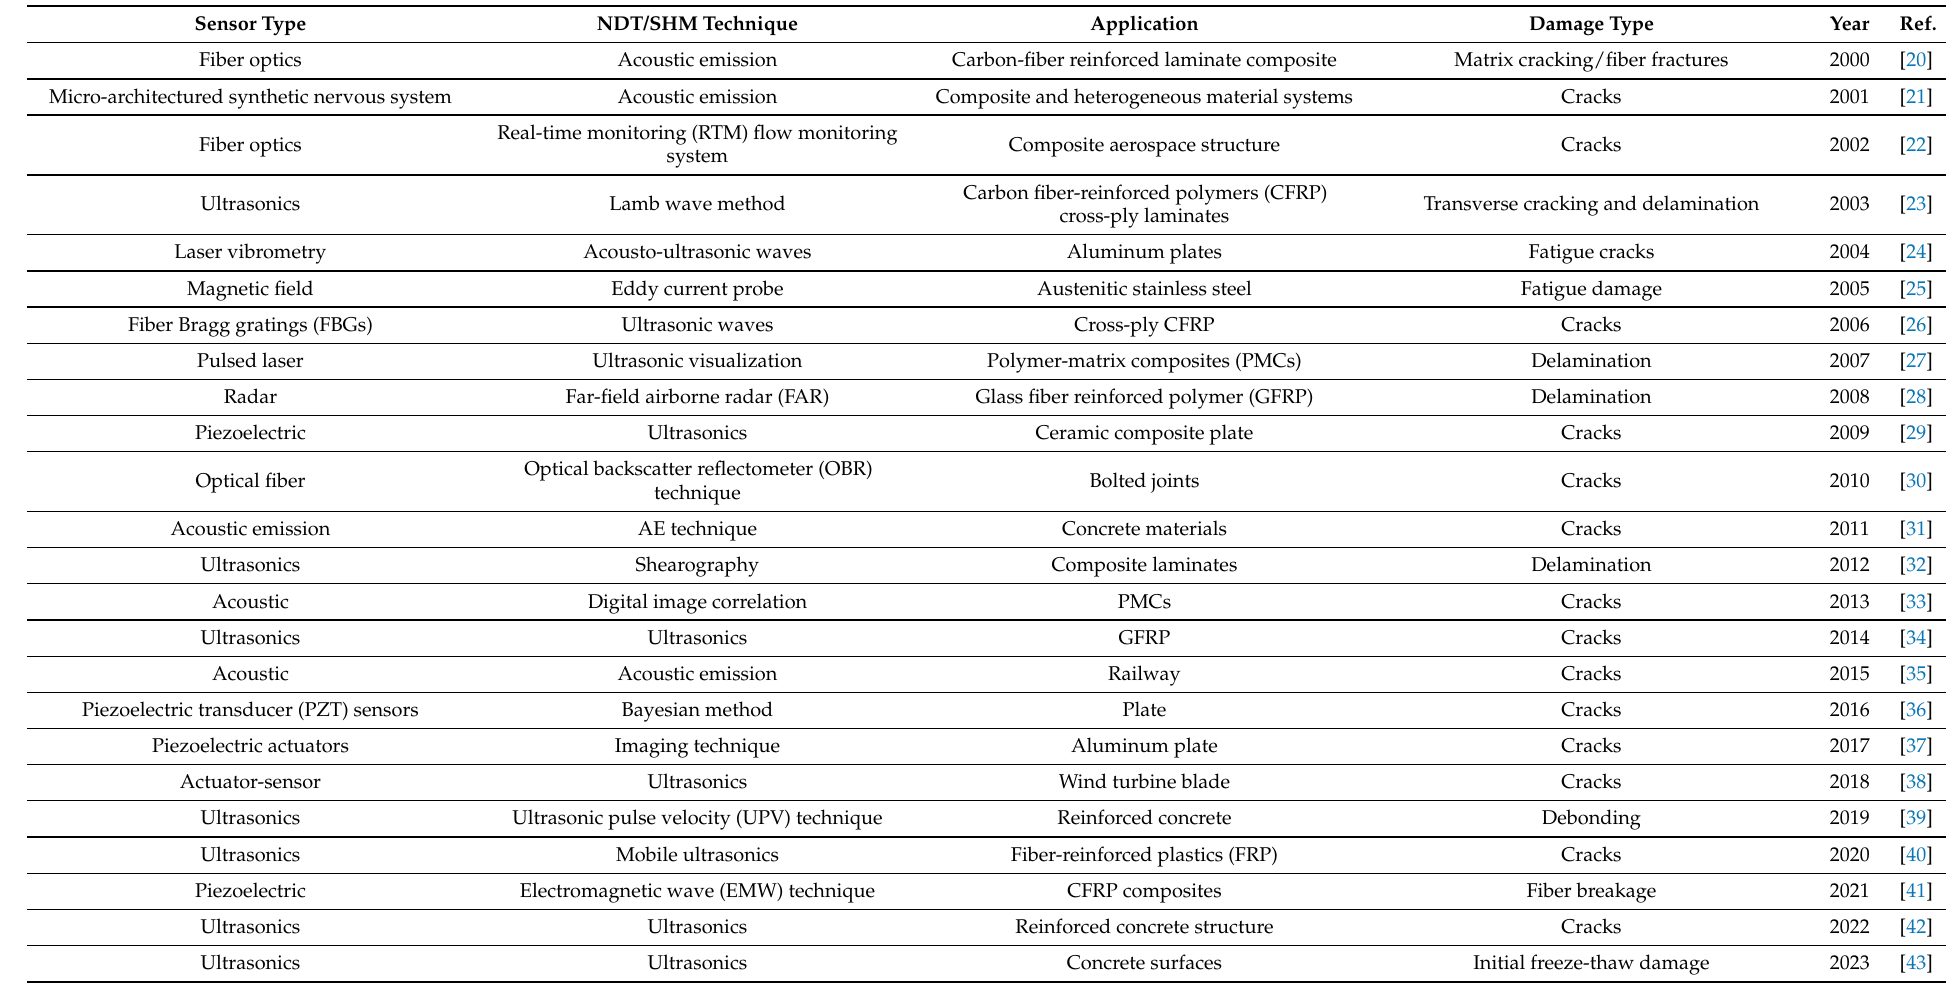
Table 1. Examples of recent research on advanced sensor technologies for NDT and SHM applications (between 2000 and